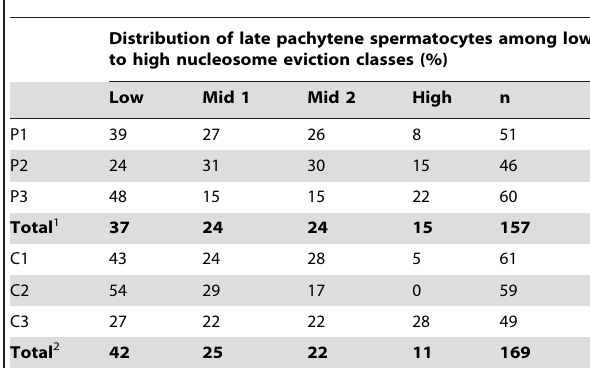
Patients (P), Controls (C). 1 Heterogeneity between patients x 2 df. 6: 13.6, p=0,035. 2 Heterogeneity between controls x 2 df. 6: 31.2, p , 0.001. Pooled patients and controls: x 2 df. 3: 2.2, p=0,54.